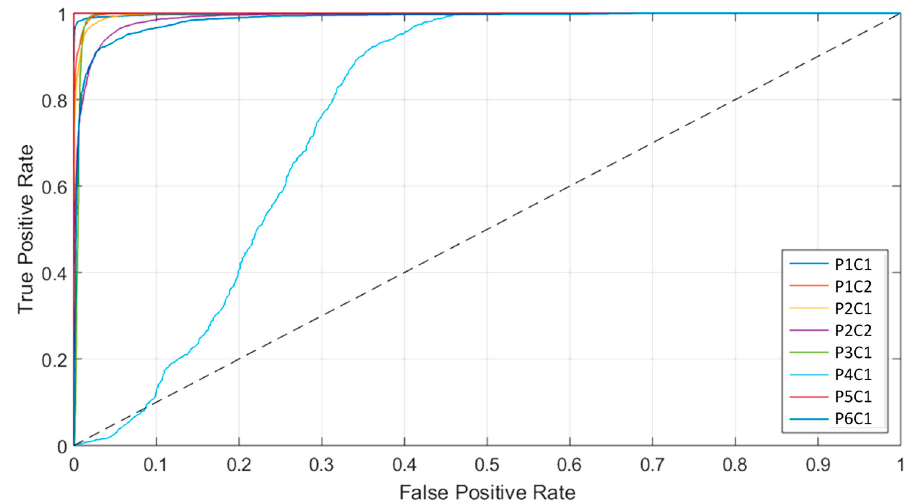
Figure 9. Receiver operating characteristic (ROC) curves of the tumor class for each image of the test dataset generated from the one-dimensional deep neural network (1D-DNN) multiclass results.